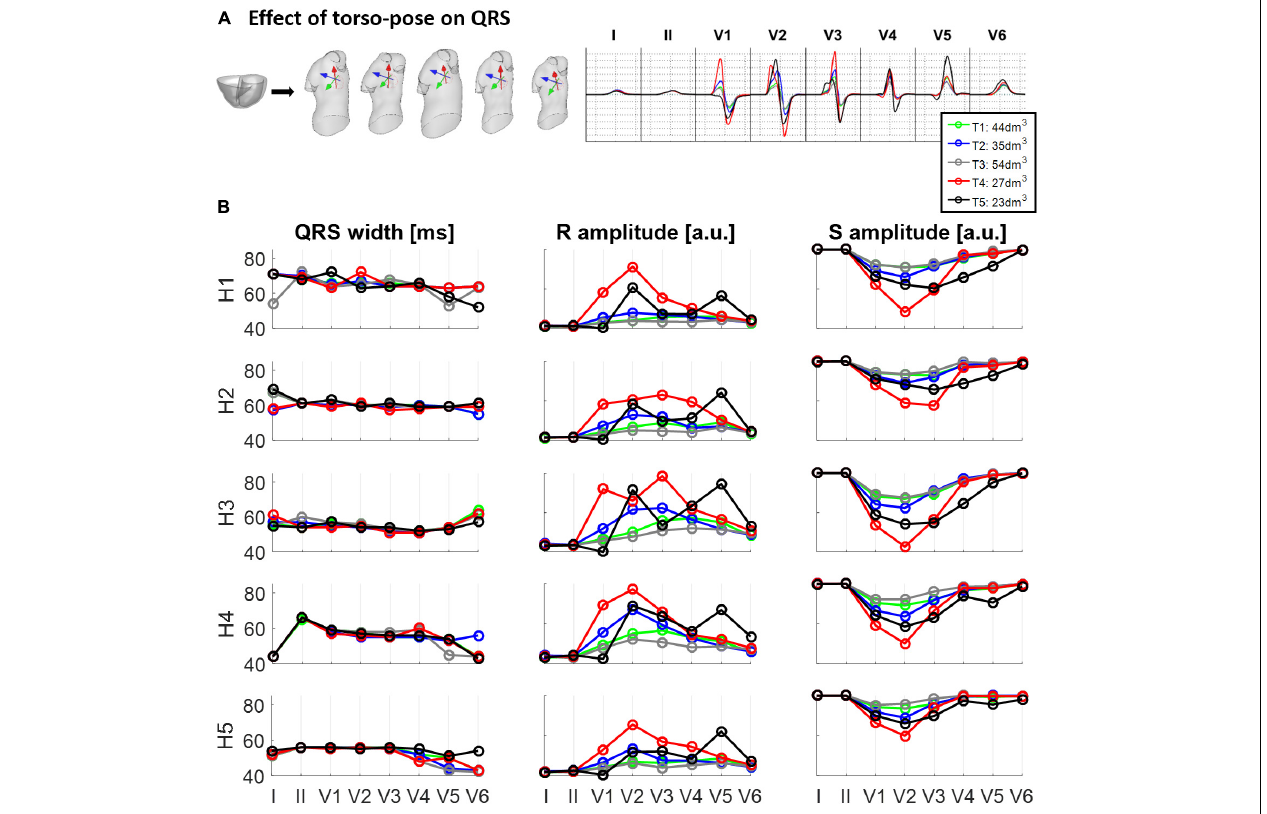
FIGURE 4 | Effect of torso-pose on QRS duration, and S and R wave amplitude. (A) Simulated QRS complexes obtained using the ventricular model from Subject 3 (H3) placed in the five different torsos-poses. (B) QRS duration (left), and S and R amplitudes (middle and right, respectively) from simulations using each of the five hearts (H1 to H5) placed in the different torso-poses (T1 to